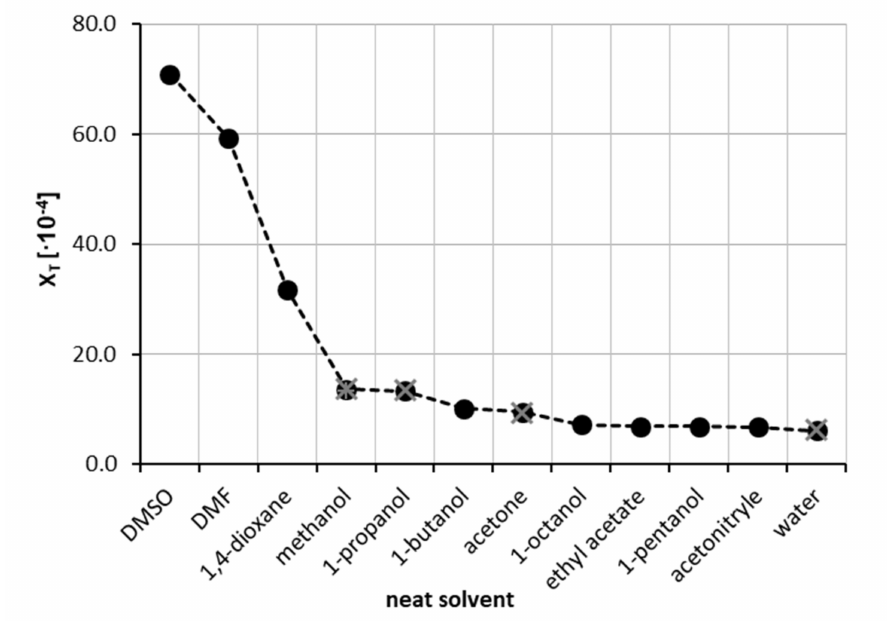
Figure 1. Solubility of theophylline at 25 ◦ C, expressed as its mole fraction, x T , in eleven neat organic solvents and water. Black circles represent measurements of this work, while grey crosses indicate values published by Zhong et al.